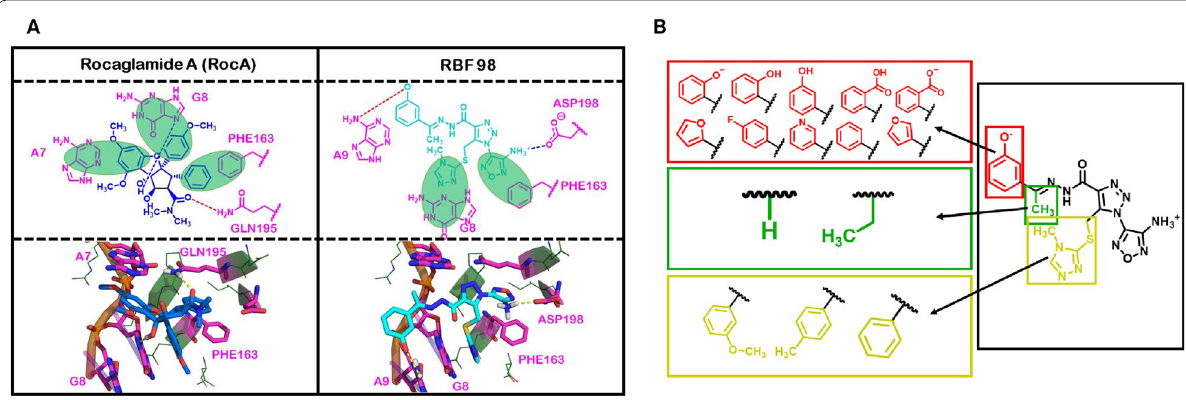
Fig. 4 Interaction differences between RocA and docked RBF98. A Interaction environments for RocA and RBF98. The above two panels show stick representations of the interactions made between RocA and RBF98 and their surrounding environments. Green, transparent ovals are used to two-dimensionally represent possible π-π stacking interactions between the ligands and surrounding residues. Dashed lines between the ligands and surrounding residues are used to indicate hydrogen bonding, where the color indicates the donor/acceptor character of the ligand atom (blue donor; red acceptor). B Summary of results from secondary screening of RBF98 analogues, purchased from MolPort. Boxes surrounding = = different moieties of RBF98 correspond by color to the larger boxes containing functional groups that were sampled as part of this secondary screen in different